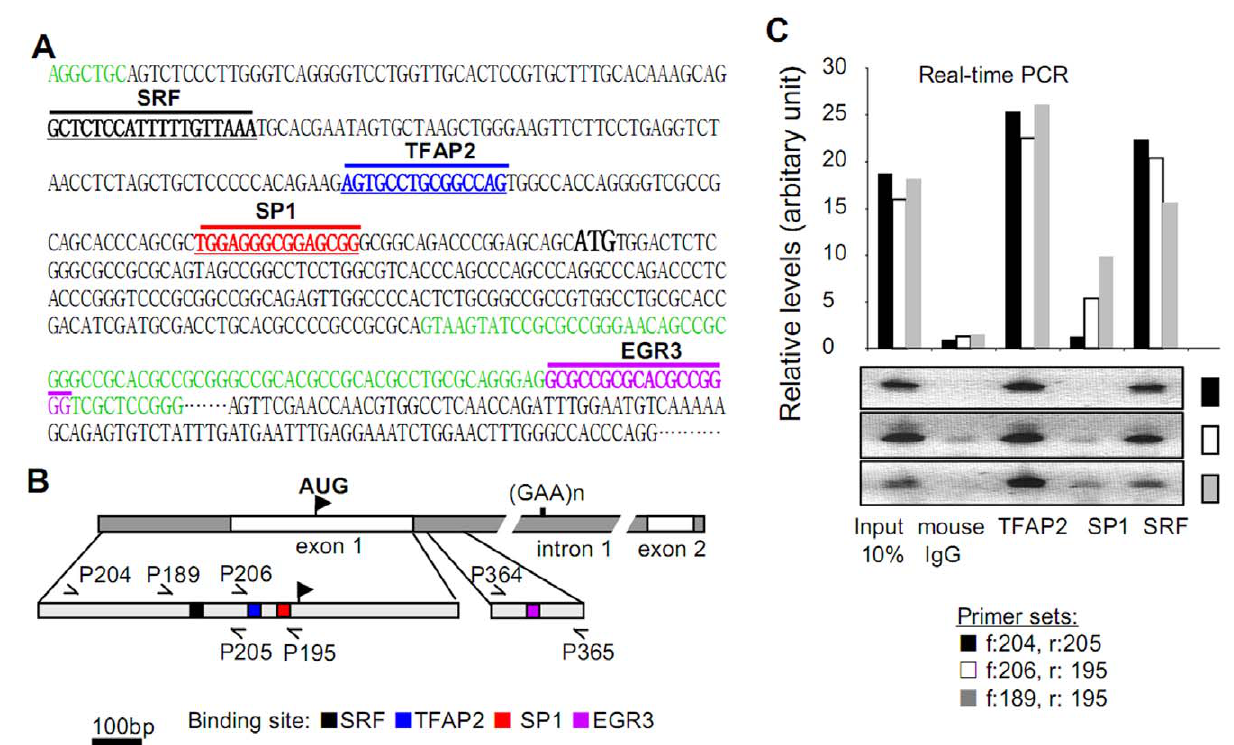
Figure 1. Transcription factors SRF and TFAP2 bind to the FXN gene promoter region invivo . (A) Sequence of 5 9 -end of the human FXN gene. Sequences are color-coded: intronic sequences in green, exon 1 and exon 2 in black. Putative transcription factor binding sites identified by Genomatix analysis are annotated in bold black for SRF, in bold blue for TFAP2, in bold red for SP1, and in bold pink for EGR3. Start codon (AUG) in exon 1 is in bold black. (B) Schematic diagram of human FXN promoter region showing the location of the putative regulatory sequences. Black-filled square: SRF binding site; blue-filled square: TFAP2 binding site; red-filled square: SP1 binding site; pink-filled square: EGR3 binding site. Primers used in the ChIP assays are designated as: P189, P195, P204, P205, P206, P364, and P365. (C) Binding of SRF and TFAP2 to the FXN promoter in vivo was quantified by chromatin immunoprecipitation (ChIP) and quantitative real-time PCR (qRT-PCR). The upper panel is the quantification of FXN promoter chromatin, immunoprecipitated using antibodies raised against SRF, TFAP2, and SP1. Three pairs of primers flanking the putative binding sites of these transcription factors were used for the qPCR analysis. The lower panel shows the end-products of the qPCR reactions separated by agarose gel electrophoresis. Primers specific for human FXN intron 4 were included as an internal negative control (data not shown).